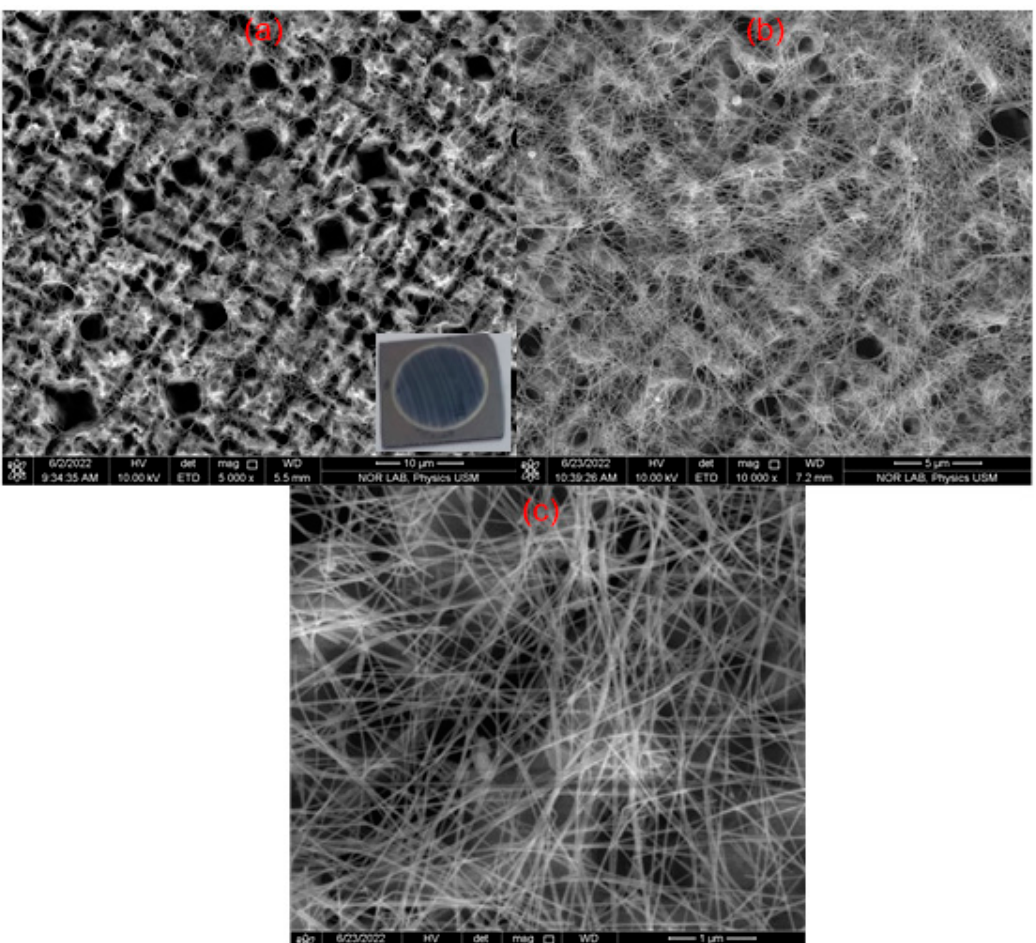
Figure 10. Schematic diagram of (a) the fabricated P-Si photodetector, (b) the AgNWs/P-Si photodetector, and (c) the photo-response analysis .